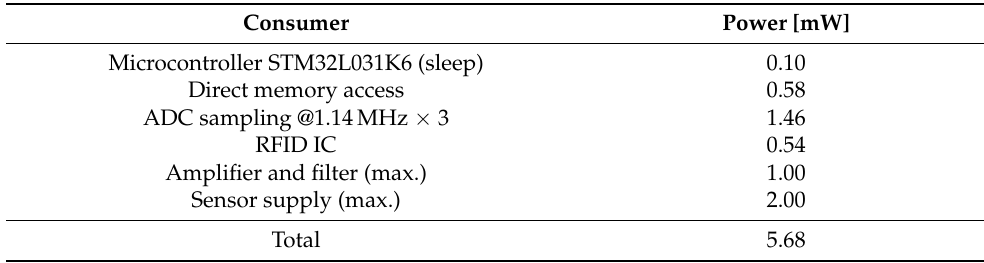
Table 4. Power requirements of an SHM sensor